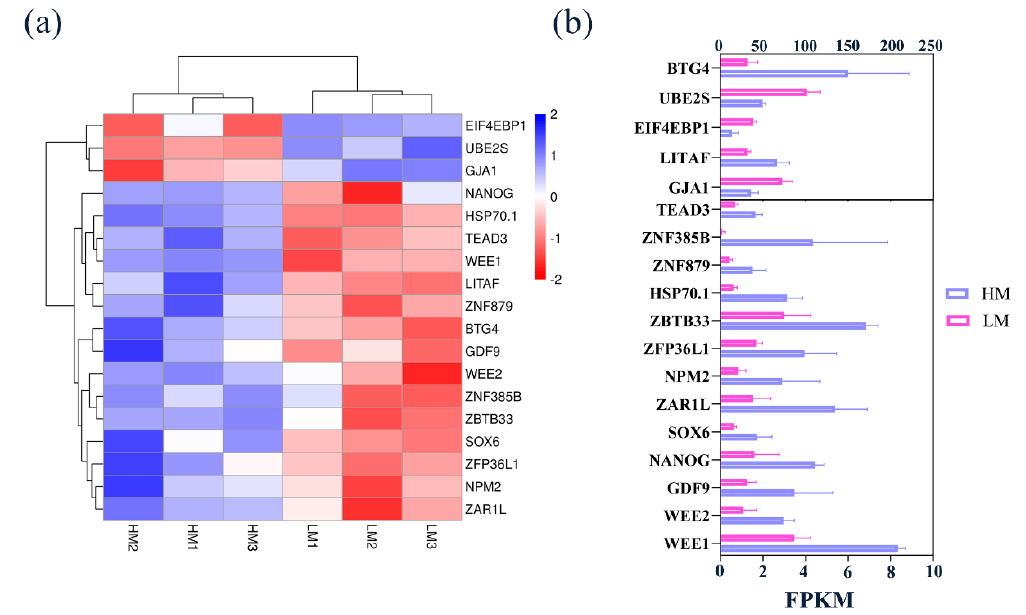
Figure 7. Analysis of DEGs that regulate embryonic development and validation of sequencing results. ( a ) Heatmap analysis of the 18 DEGs (zygotic genes, transcription factors, and maternal genes). ( b ) The histogram of FPKM of zygotic genes, transcription factors, and maternal genes.